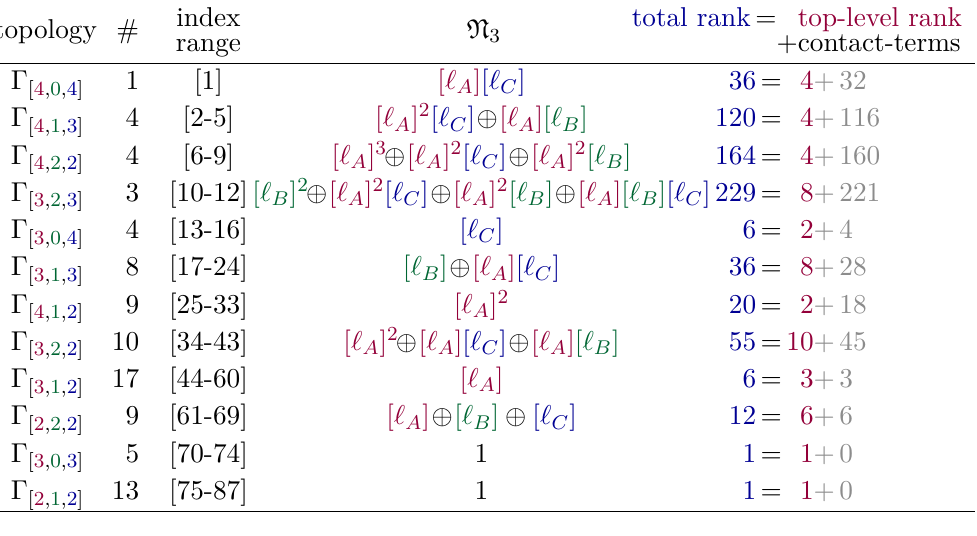
Table 2 . Enumeration of the topology distributions and rank-counts for graphs with six external legs. The index ranges are those used to identify integrands in the supplementary material.